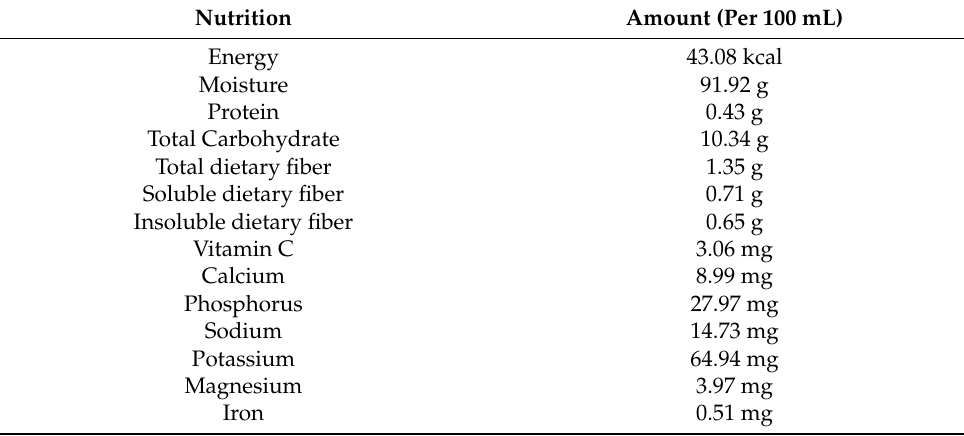
Table 2. Nutritional value of the vegetable and fruit juice